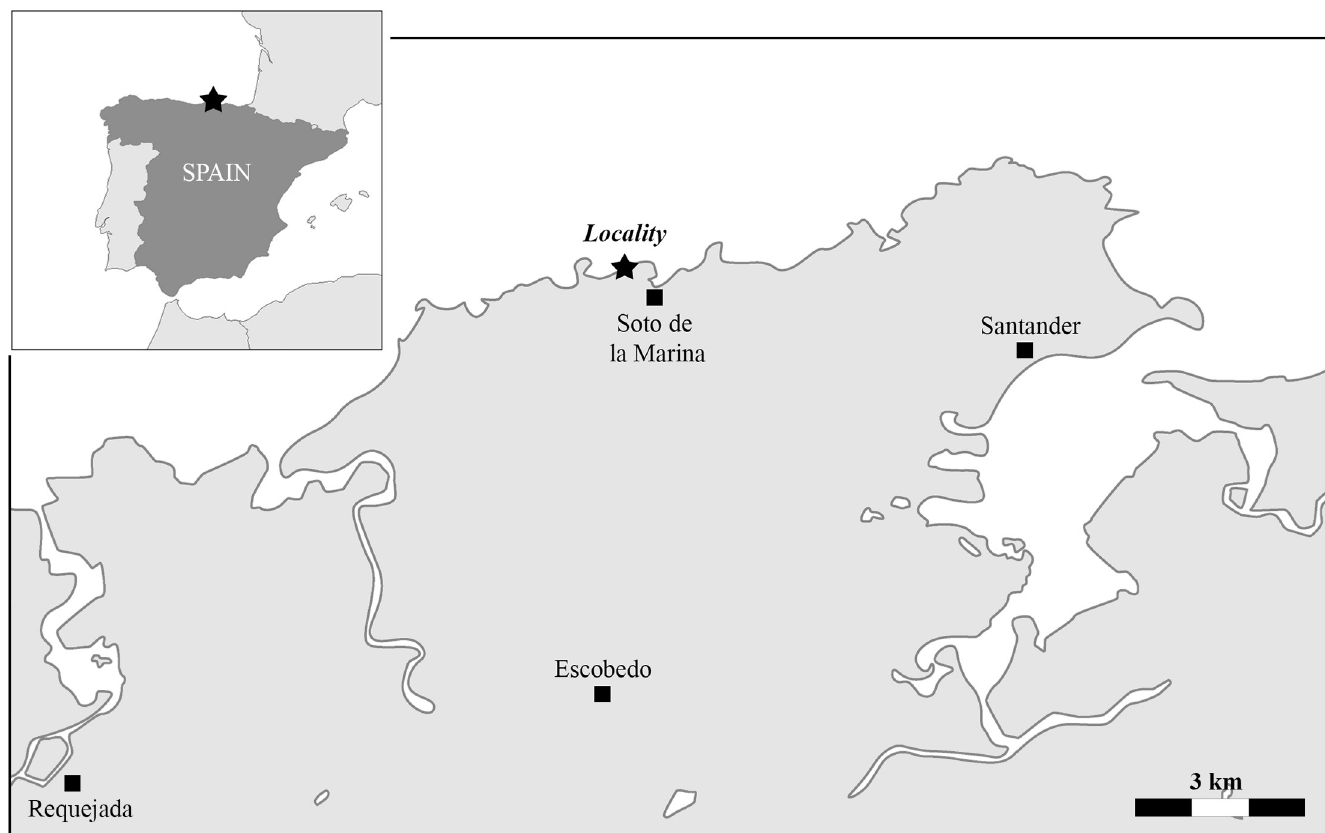
Fig 1. Fossil locality near Santander, northern Spain where EMRG-Chond-SK-1 was recovered (indicated by a black